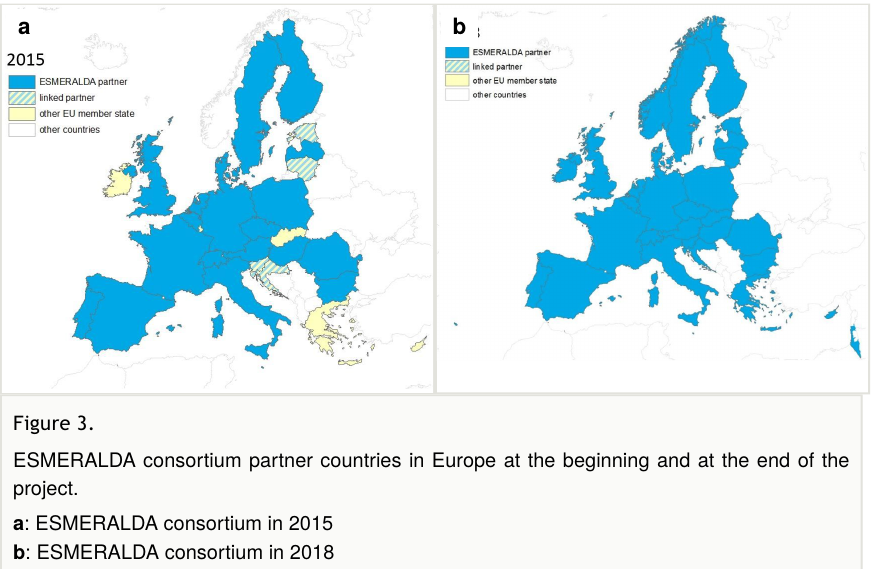
ESMERALDA consortium partner countries in Europe at the beginning and at the end of the